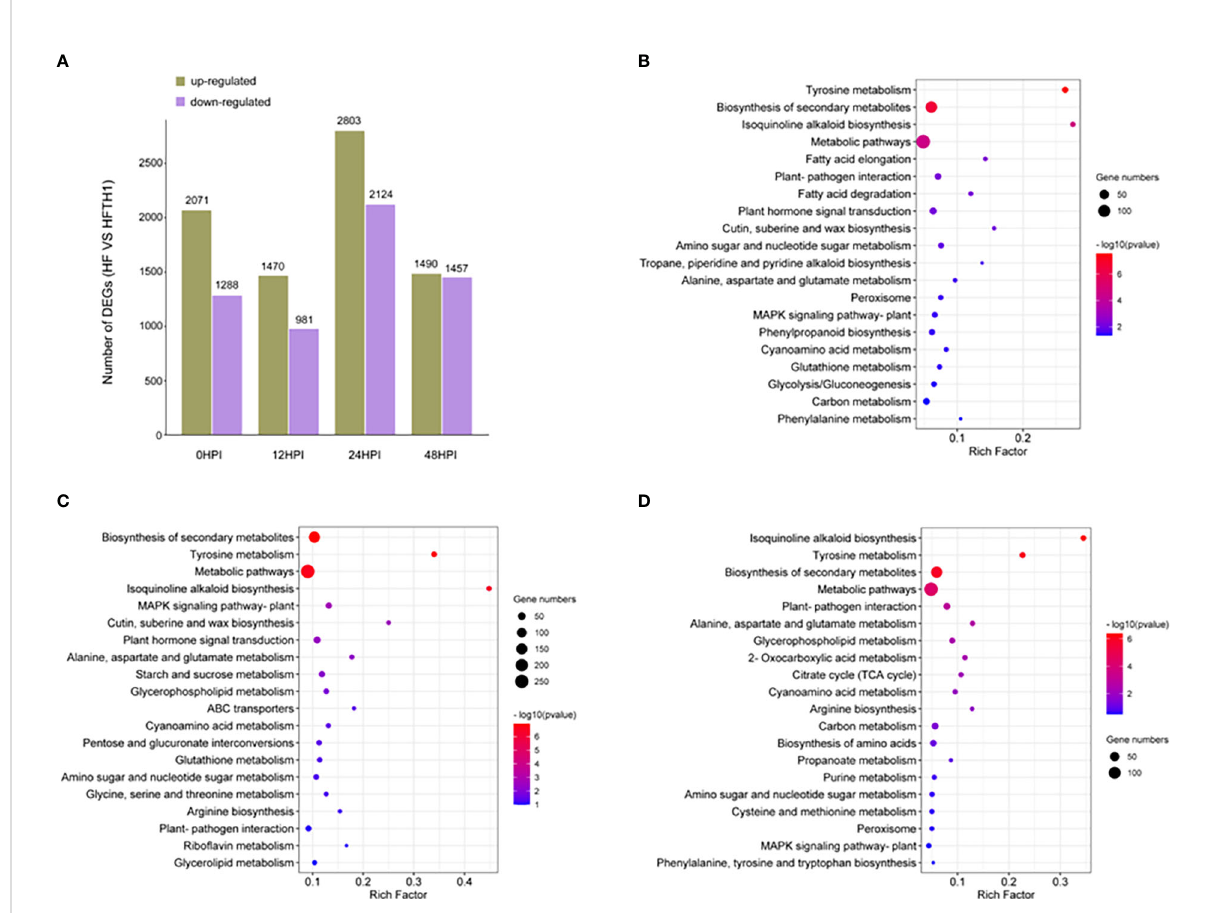
FIGURE 4 Comparative transcriptomic analysis of HFTH1 and HF before and after AAAP infection. (A) DEGs in HF compared with HFTH1 at the same time before and after AAAP infection. (B – D) Compared with HFTH1, HF up-regulated the KEGG pathway with signi fi cant enrichment of DEGs at 12 HPI (B) , 24 HPI, and (C) and 48 HPI (D)